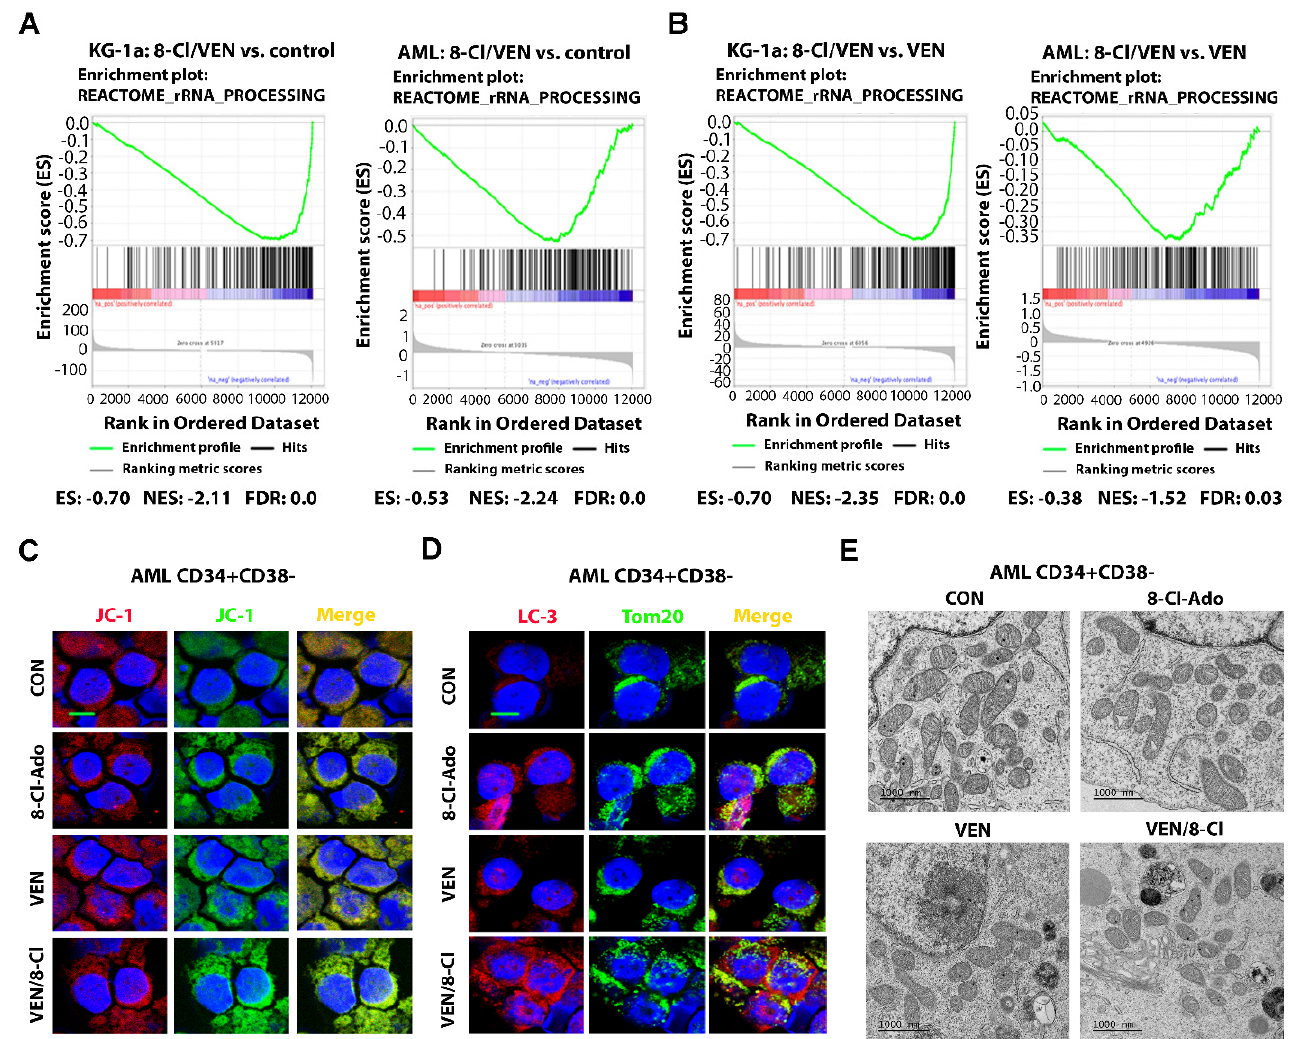
Figure 4. Effects of 8-Cl-Ado plus VEN on rRNA synthesis and mitochondria metabolism. LSC- enriched blasts and KG-1a cells were treated with 500 nM 8-Cl-Ado, 10 nM VEN or both. ( A , B ) Gene set enrichment analysis (GSEA) graphs of genes involved in rRNA synthesis upon treatment of KG-1a and primary AML blast cells for 24 h. GSEA of rRNA synthesis for direct comparison of VEN/8-Cl-Ado versus control ( A ) or VEN ( B ). n = 2. ES enrichment score, NES normalized enrichment score, FDR false discovery rate. ( C ) Mitochondrial membrane potential was measured by staining of the treated cells with JC-1 probe. The red and green fluorescence is indicative of JC-1 polymer and monomer, respectively. Scale bar, 10 µ m. ( D ) Mitophagy marker LC3 and mitochondria marker TOM20 were measured by immunofluorescence staining. Scale bar, 10 µ m. ( E ) Mitochondria morphology was measured by electron microscope imaging. Scale bar, 1000 nm. CON, control; VEH, vehicle; VEN, venetoclax; 8-Cl-Ado,